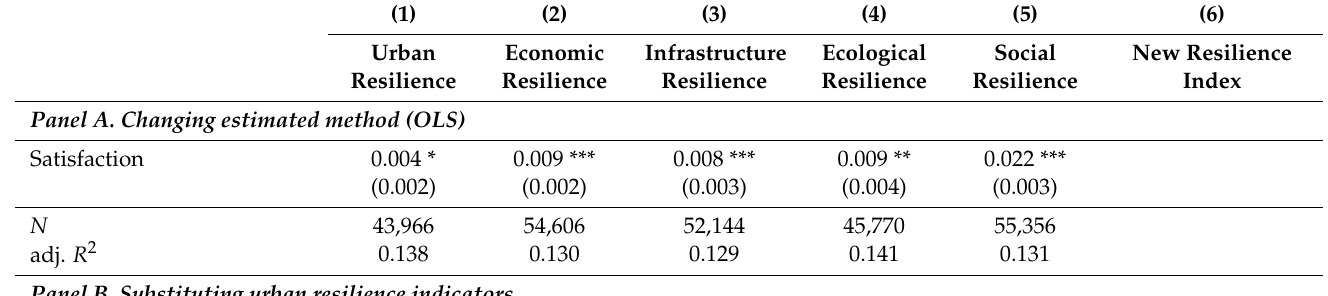
Table 8. Robustness checks after changing estimation models or substituting